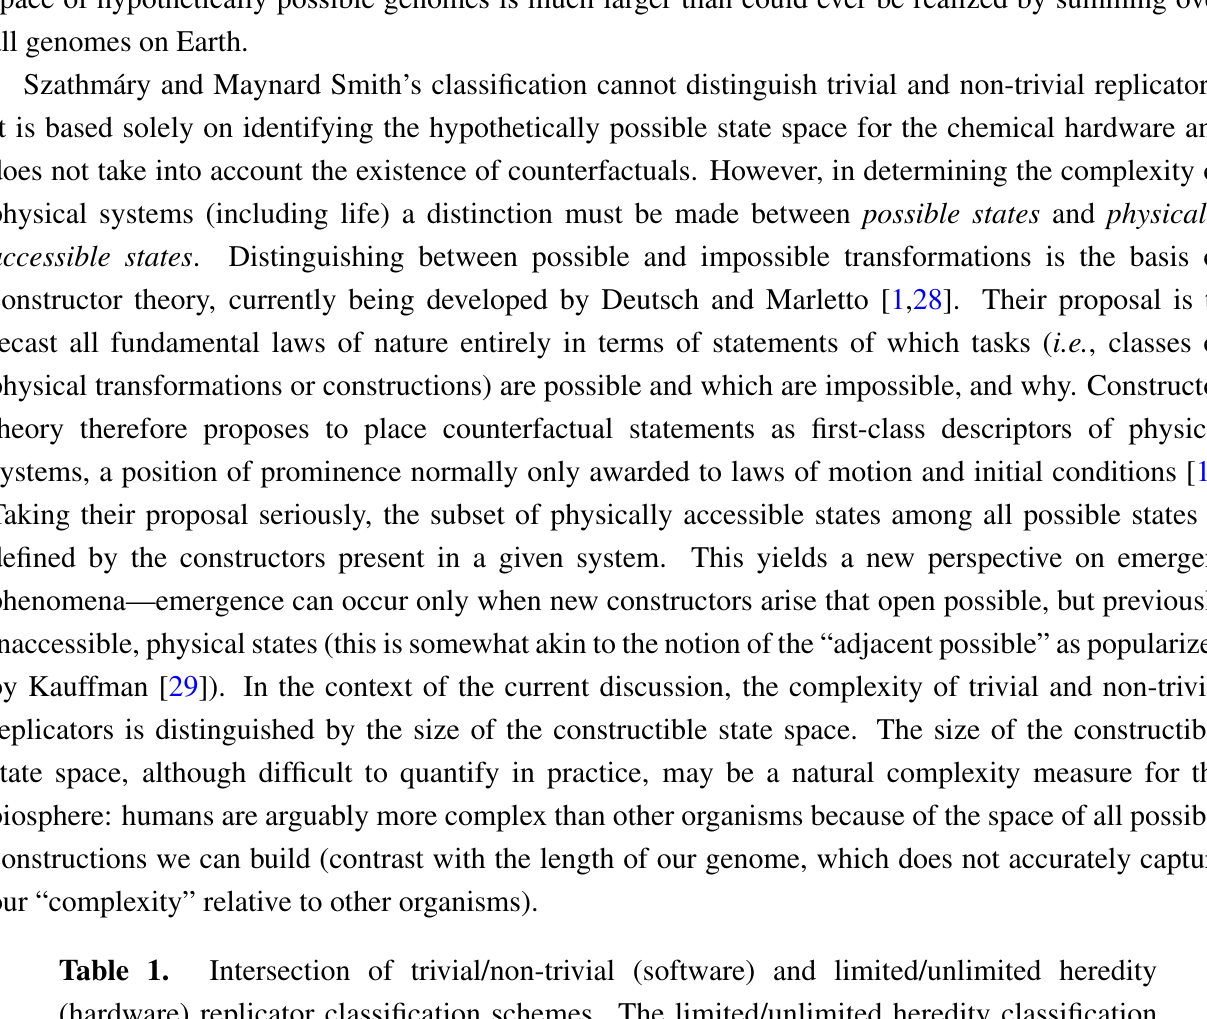
Table 1. Intersection of trivial/non-trivial (software) and limited/unlimited